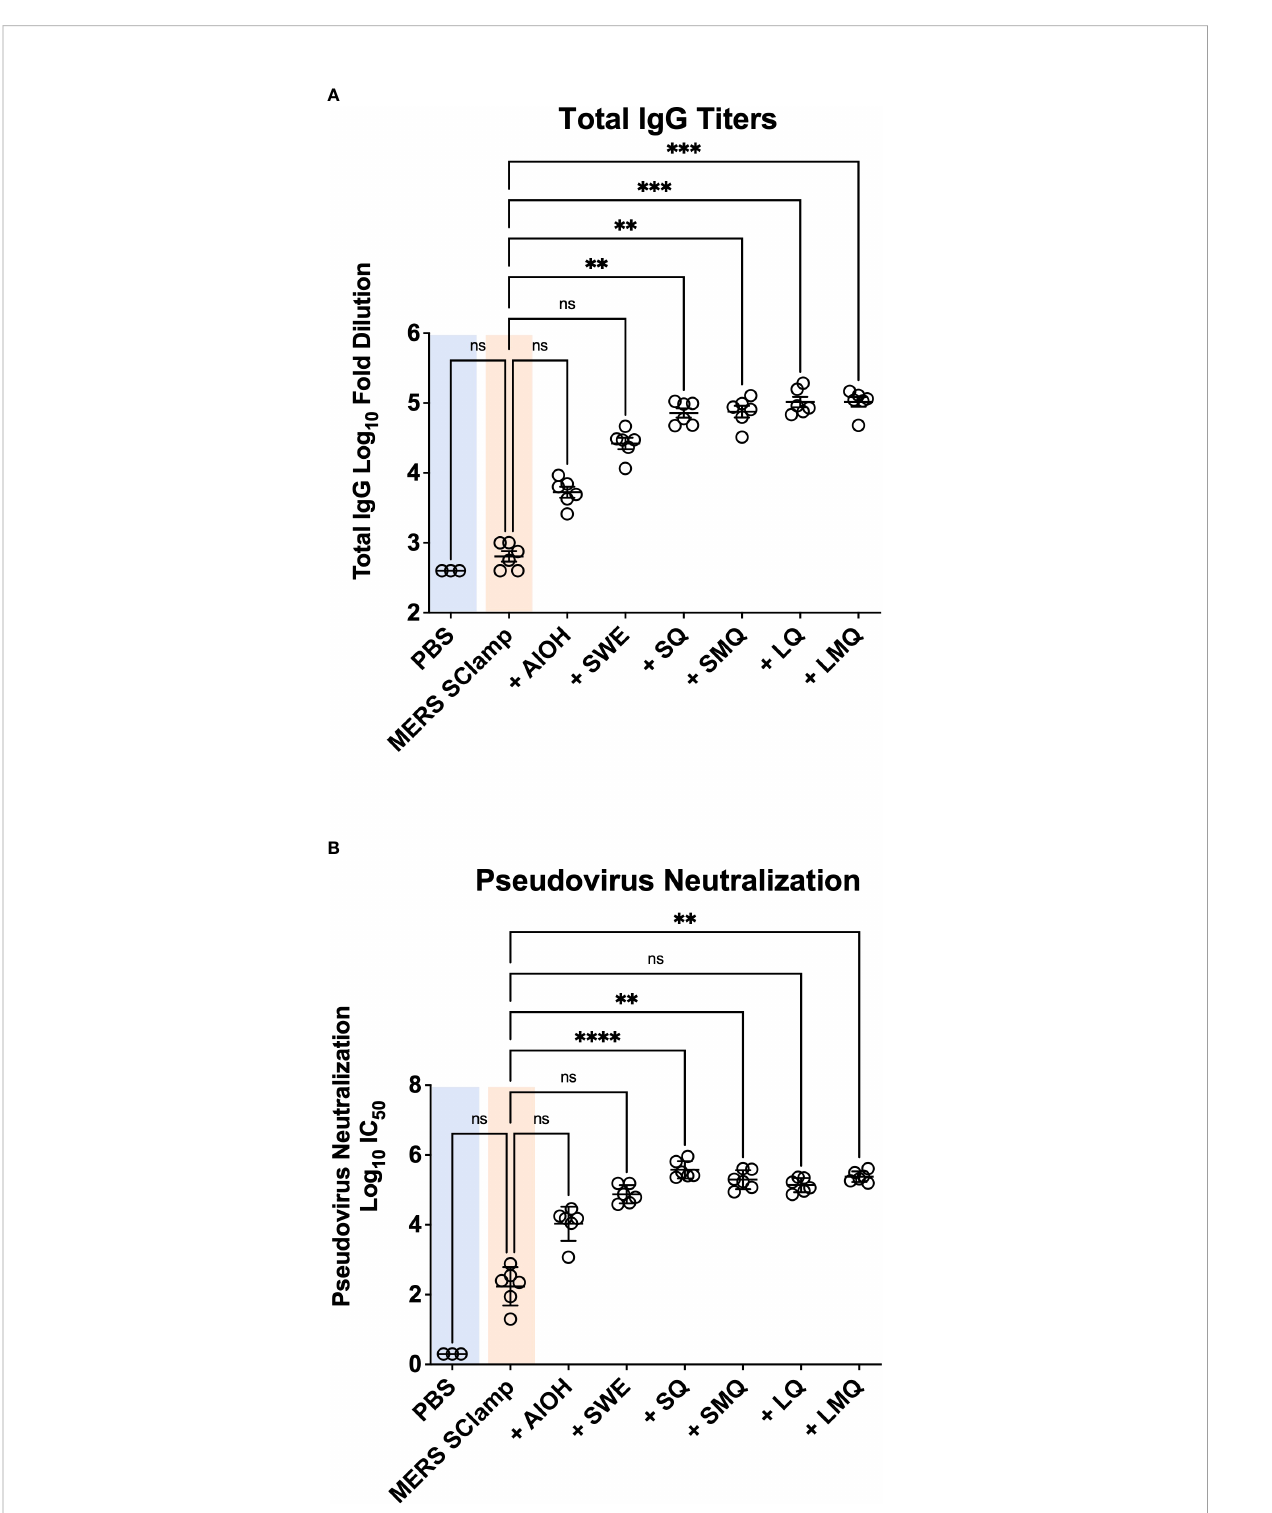
FIGURE 1 Vaccine adjuvanticity impacts antibody titer and neutralization. Following immunization of C57BL/6 mice with either PBS or clamped MERS antigen (MERS SClamp) (1µg/dose) +/- either AlOH salts, SWE, SQ, SMQ, LQ, or LMQ adjuvants (A) ELISAs showing anti-MERS IgG titer of serum from treated mice. (B) From the same experiment as (A) , IC 50 of MERS pseudovirus neutralization with anti-MERS IgG of serum from mice treated with either MERS SClamp antigen +/- adjuvants. Individual data point have been presented with mean +/- SEM. Kruskal-Wallis with Dunn ’ s test, ns = P>0.05, **P<0.01, ***P<0.001, and ****P<0.0001. Experiment completed once, n = 3 – 6 mice/group. Related to Figure